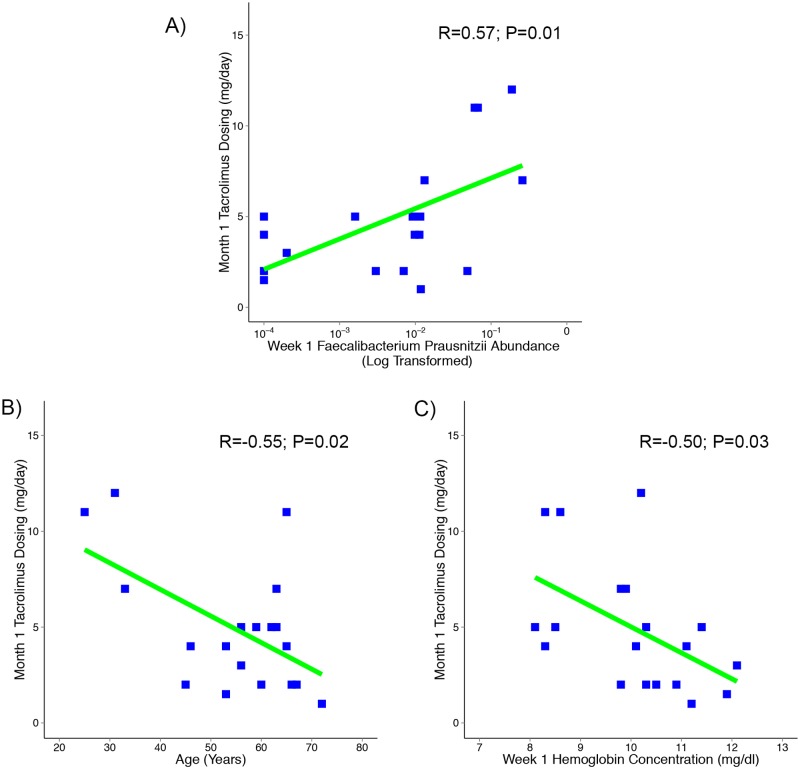
Correlations with Tacrolimus Dosing at 1 Month.A) Fecal Faecalibacterium prausnitzii abundance at 1 week post-transplantation is associated with tacrolimus dosing at 1 month. On the x-axis is the log transformed fecal week 1 Faecalibacterium prausnitzii abundance and on the y-axis is the corresponding subject’s tacrolimus dosing at 1 month (mg/day). There was a positive correlation between the log-transformed fecal week 1 Faecalibacterium prausnitzii abundance and tacrolimus dosing at 1 month (Pearson R = 0.57, P = 0.01). B) Age at transplantation is negatively associated with tacrolimus dosing at 1 month. On the x-axis is the age at transplantation and on the y-axis is the corresponding subject’s tacrolimus dosing at 1 month (mg/day). There was a negative correlation between age and tacrolimus dosing at 1 month (Pearson R = -0.55, P = 0.02). C) Post-transplantation week 1 hemoglobin concentration is negatively associated with tacrolimus dosing at 1 month. On the x-axis is the week 1 hemoglobin concentration and on the y-axis is the corresponding subject’s tacrolimus dosing at 1 month (mg/day). There was a negative correlation between week 1 hemoglobin concentration and tacrolimus dosing at 1 month (Pearson R = -0.50, P = 0.03).